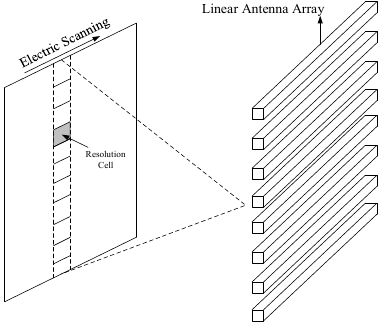
Figure 1. The hybrid architecture of phased array and aperture synthesis .